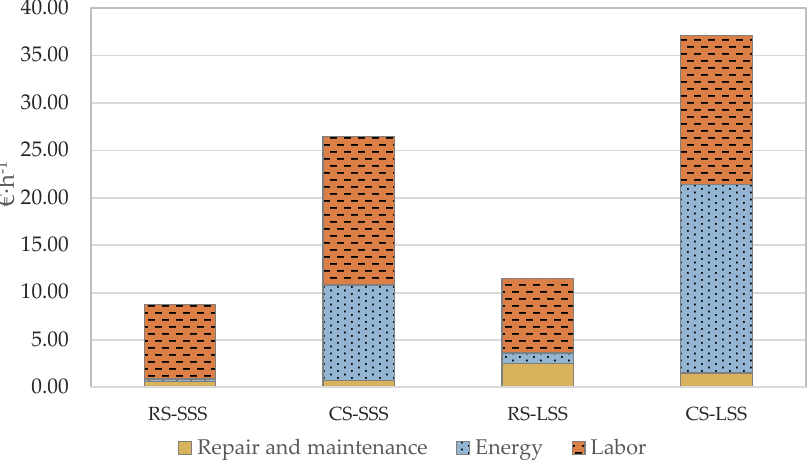
Figure 7. Operation cost per unit time analysis (RS—Robotic System; CS—Conventional System; SSS—Small-Scale Scenario; LSS—Large-Scale Scenario).